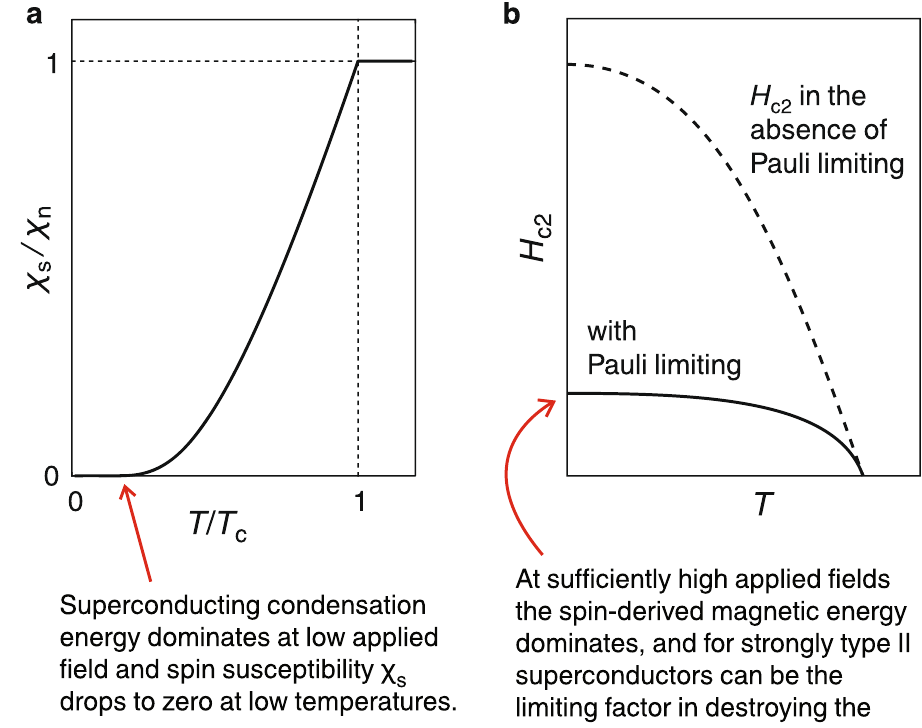
Fig. 5 Sketches illustrating the competition between spin polarisation energy and superconducting condensation energy in classic even parity superconductors with spin singlet pairing. Because a singlet Cooper pair is non-magnetic, the magnetic spin polarisation energy gain is lost when the condensate is fully formed at low temperatures. If the applied fi eld is low ( a )) this means that the spin susceptibility is quenched. However, if the applied fi eld is suf fi ciently high, the spin polarisation energy gain wins out, and the superconductivity is destroyed ( b )). Although these sketches are for even parity superconductors in the absence of spin-orbit coupling, and the situation in Sr 2 RuO 4 is much more complicated, the qualitative relationship between the two measurements would naively be expected to persist. It is thus a major discrepancy that critical fi eld limiting is clearly seen in Sr 2 RuO 4 but is not accompanied by a decrease of the Knight shift below T c